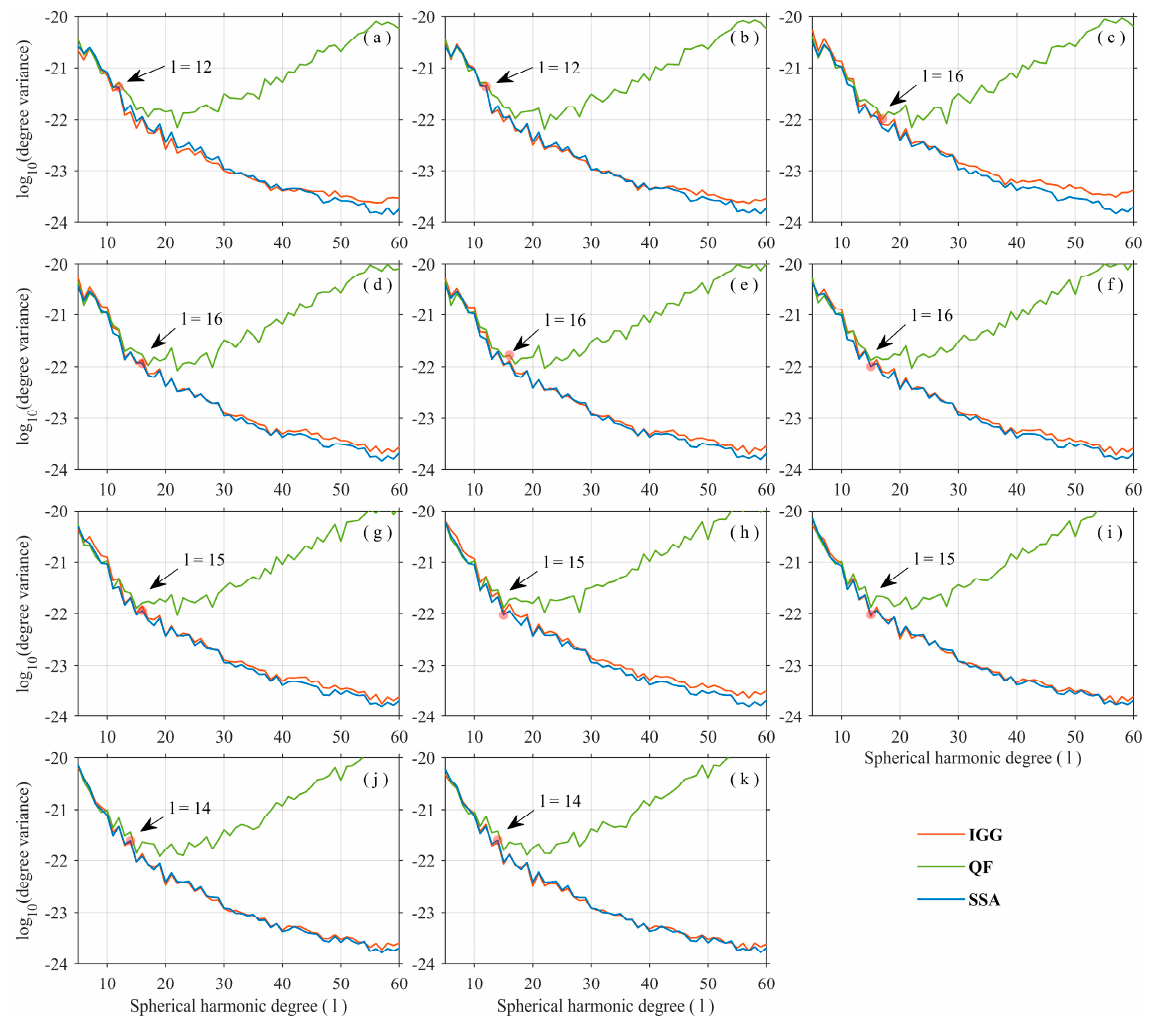
Figure 3. Logarithmic (base 10) variances versus degree of SHCs of the IGG, QF, and SSA data during the 11-month gap (July 2017–May 2018). ( a – k ) denote the time series from July 2017 to May 2018, respectively.